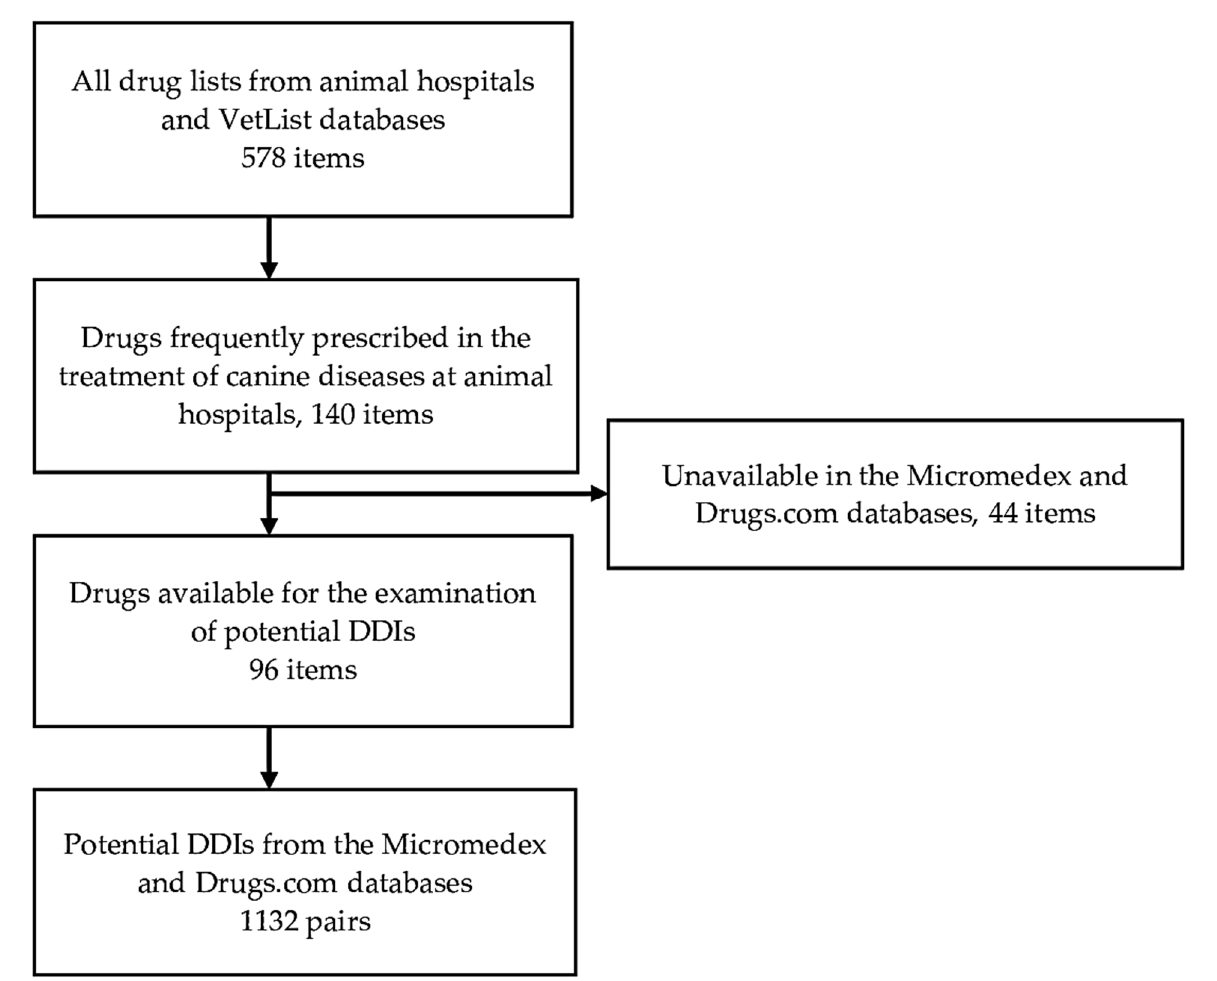
Figure 1. Procedure for drug selection. DDIs: drug–drug interactions. Table 1. List of drugs used for the potential DDI analysis.